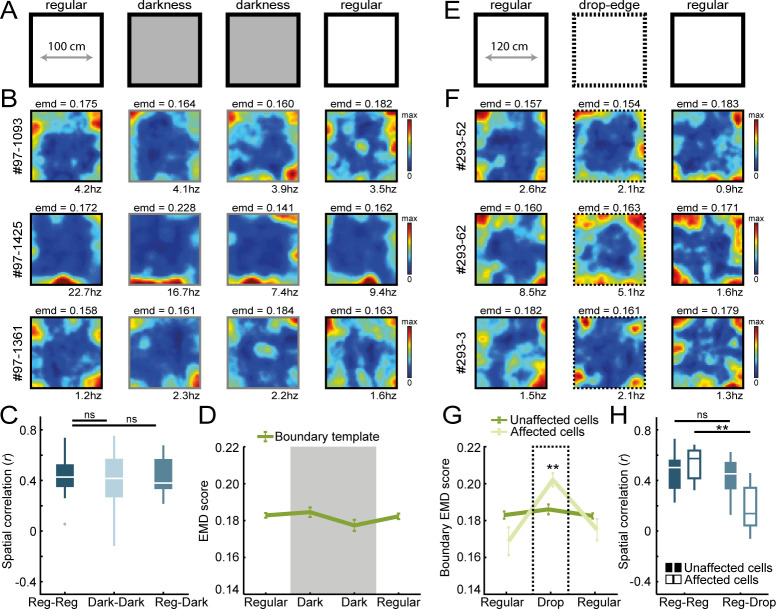
Border coding is maintained in darkness and in the absence of physical walls.(A) Recordings were performed under no visible light in the middle sessions, and the animal’s position was tracked in the infrared spectrum. (B) Spatial rate maps of three typical border cells recorded in light and dark conditions. (C) Spatial correlations between rate maps of regular and dark sessions remained high, indicating border cells still fired nearby boundaries in darkness. (D) There were no changes in EMD scores with the boundary template, confirming that cells maintained their tuning to the outer walls without direct visual detection. (E) All four outer walls were removed, leaving only a drop-edge to confine the arena. (F) Spatial rate maps of three example border cells across recording sessions. (G) Spatial rate maps were maintained for a majority of border cells (unaffected) but a subset of neurons showed disrupted firing near the drop-edge that resulted in an increase in the EMD score on the boundary template (affected). (H) Spatial correlations between rate maps of regular and drop-edge sessions remained high for the unaffected cells but decreased significantly for the affected cells. **p<0.01, Wilcoxon signed-rank test.